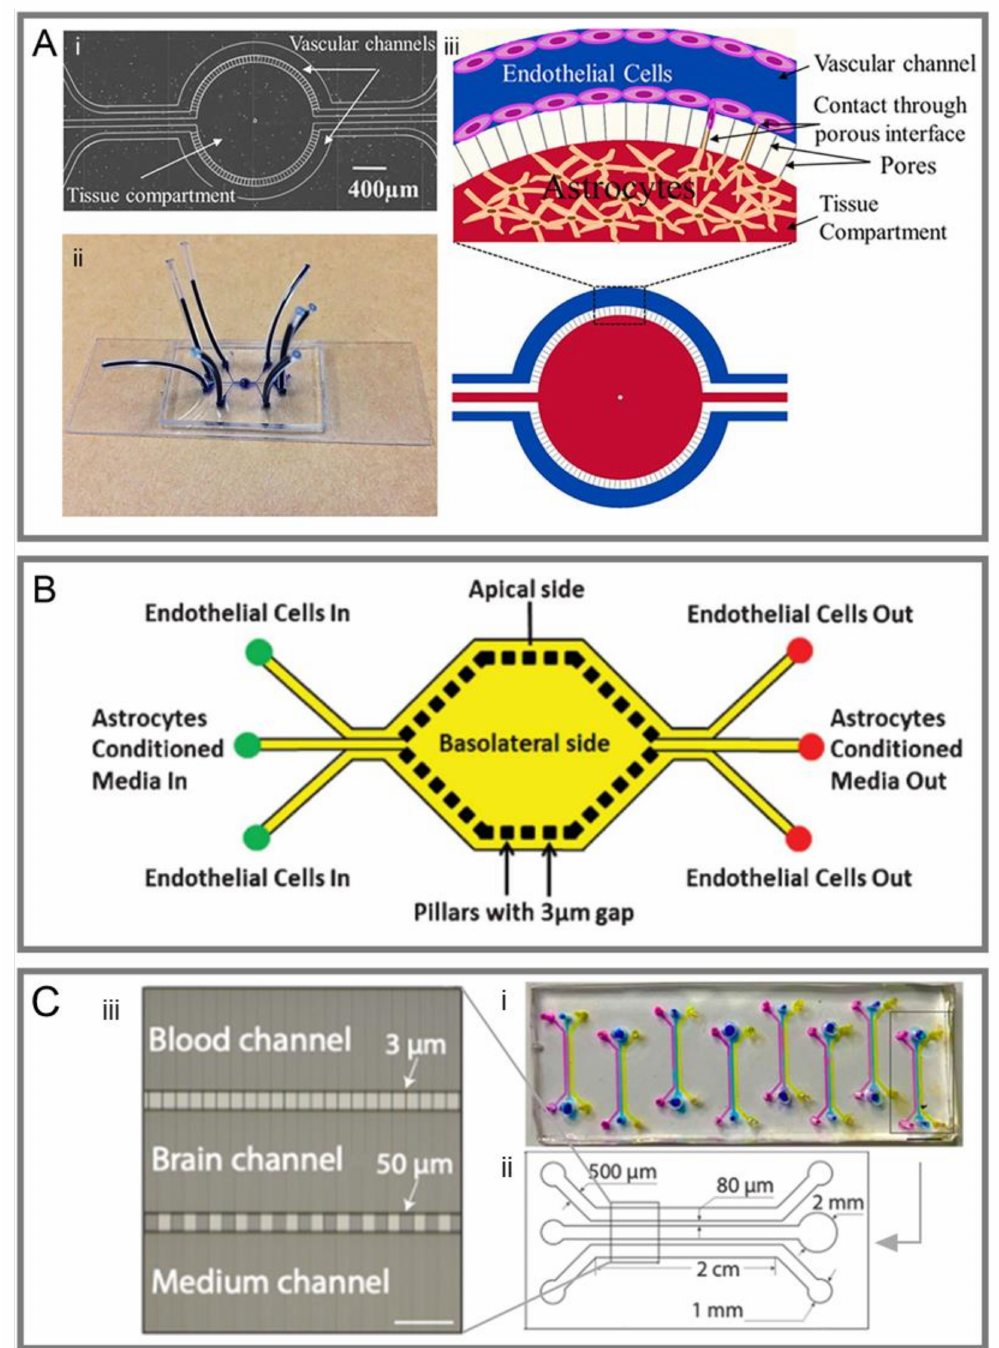
Figure 3. Schematic of different 2D models of BOCs. ( A-i ) The mask design of a microfluidic chip consisting of circular vascular channels and tissue compartment. ( A-ii ) The fabricated BOC on a microscope glass slide with plastic tubing and individual vascular channels and the tissue compartment stained (dark blue). ( A-iii ) Schematic illustration of cell culture in the BOC showing the endothelial cell lining on the walls of the vascular channel (blue), astrocytes contained in the tissue compartment (red), and their contact through the porous interface [74]. ( B ) Another design of 2D BOC with the apical and basolateral sides separated by 3 µ m gaps formed by microfabricated pillars. Apical side contains endothelial cells while the basolateral side contains astrocyte conditioned media [75]. ( C ) A 2D microfluidic device for high-throughput drug assessment. ( i ) Top view of